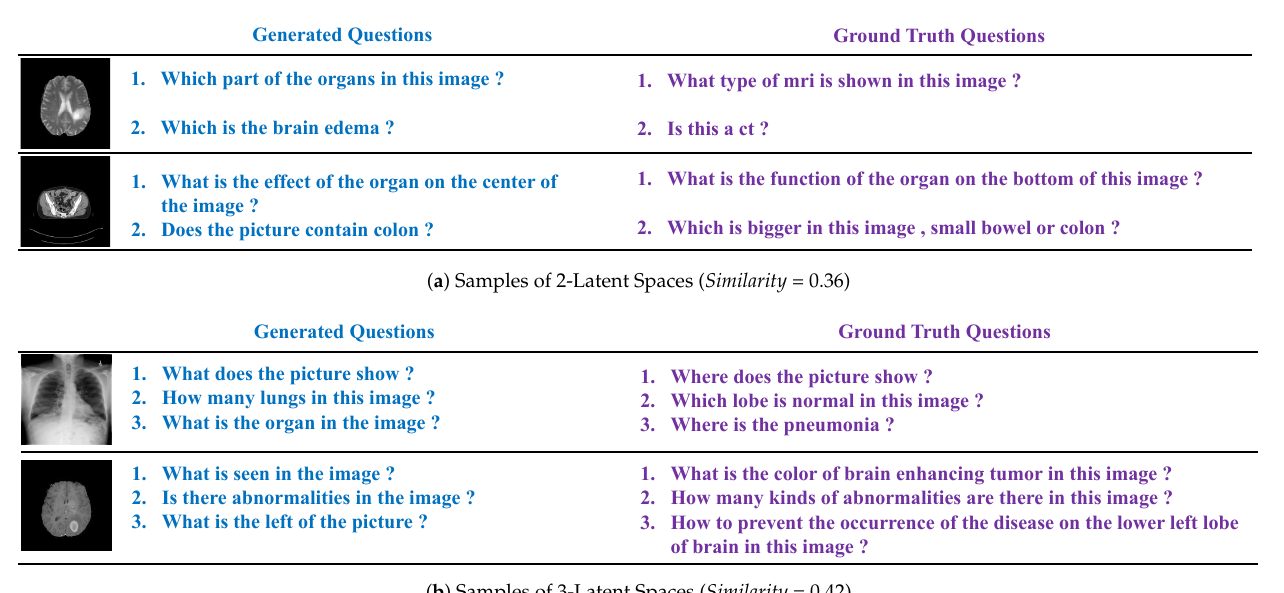
Figure 5. Similarity heatmap between the generated questions and the ground truth question sets.